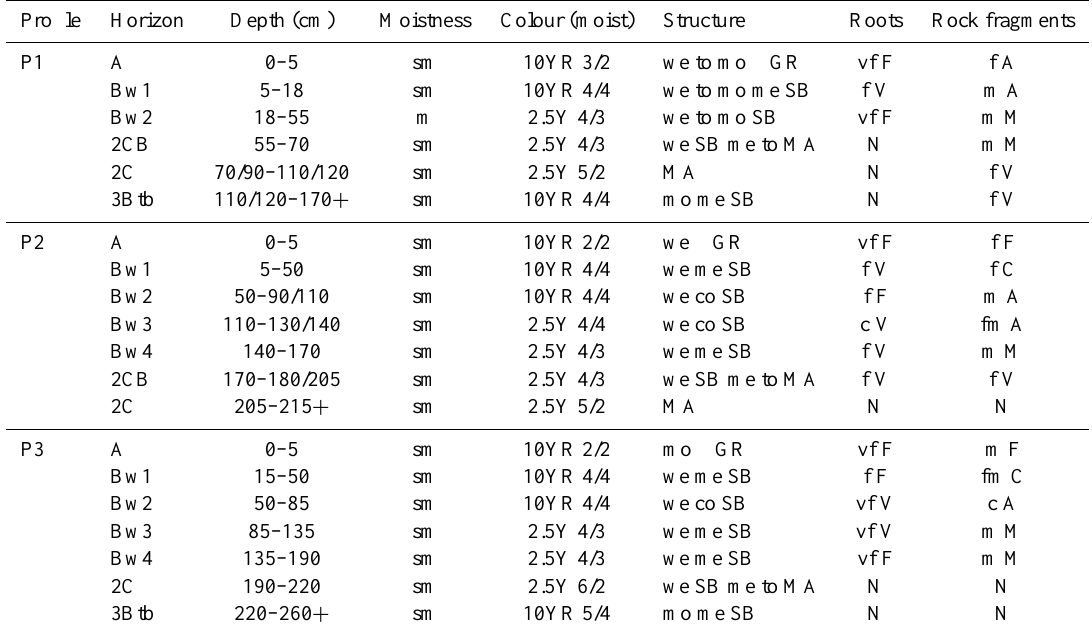
Table 1. Field morphology description of the studied soil profiles. Profile Horizon Depth (cm) Moistness Colour (moist)